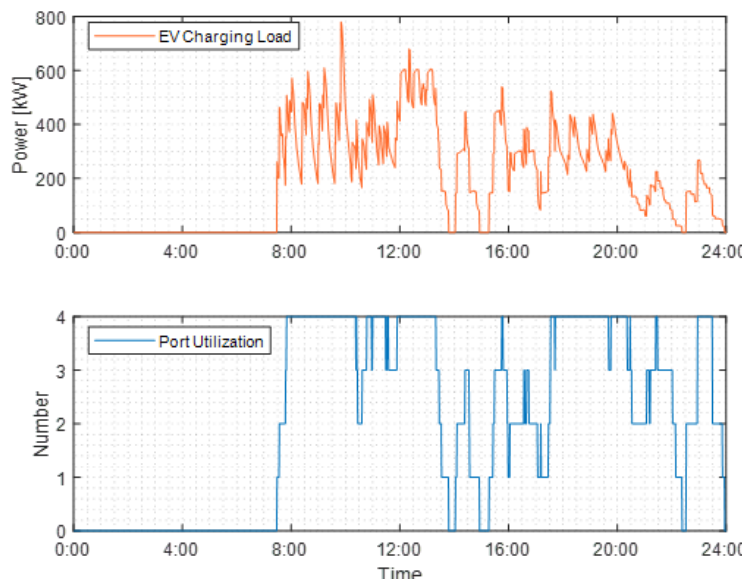
Figure 8. EV charging load and port utilization of XFC4.